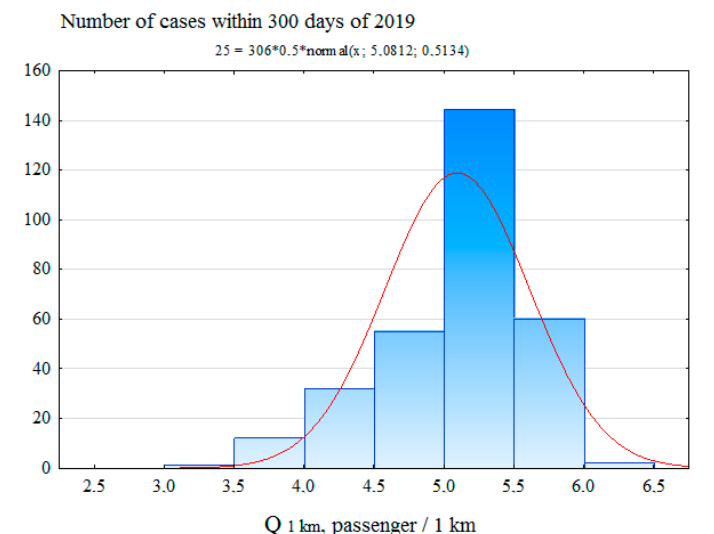
( c ) Examples of distribution of Q 1km for highly efficient routes of the Tyumen CPPT.